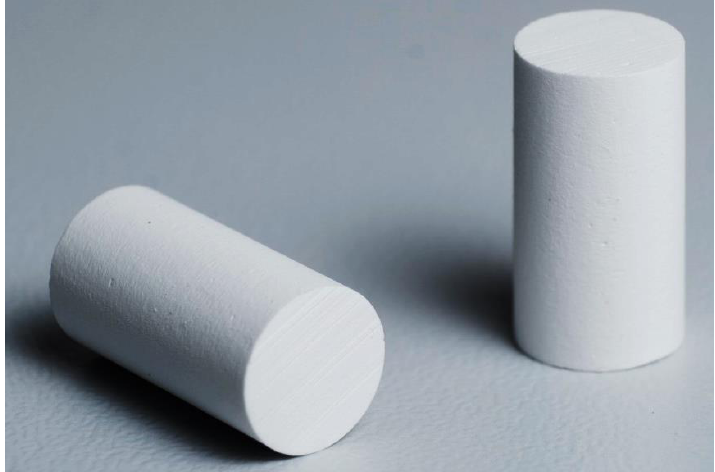
Figure 2. Close-up of the raw cylinder based on the partially sintered borosilicate glass VitraPOR 5, diameter 8 mm, length 15 mm, volume 0.75 mL.